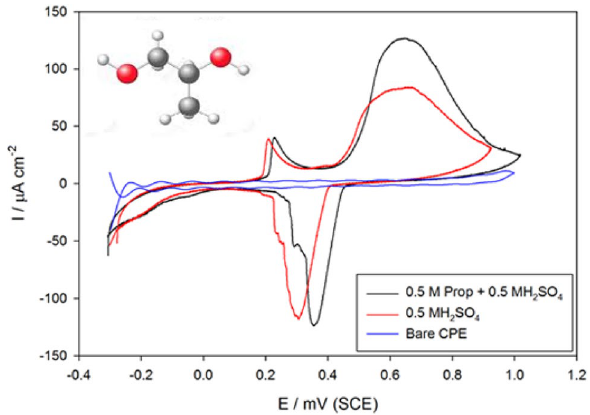
Figure 3. CVs of bare CPE in 0.5 M H 2 SO 4 and SMWZCPE in 0.5 M H 2 SO 4 with and without 0.5 M propylene glycol at scan rate of 100 mV·s -1 .